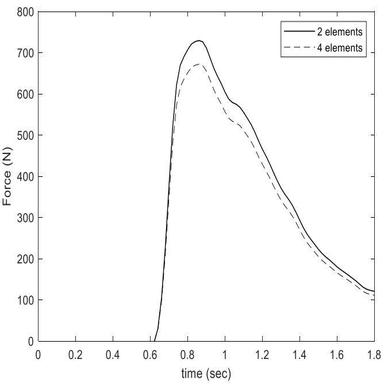
Normal force measurements from the sensitivity study on models with 50% obstruction.